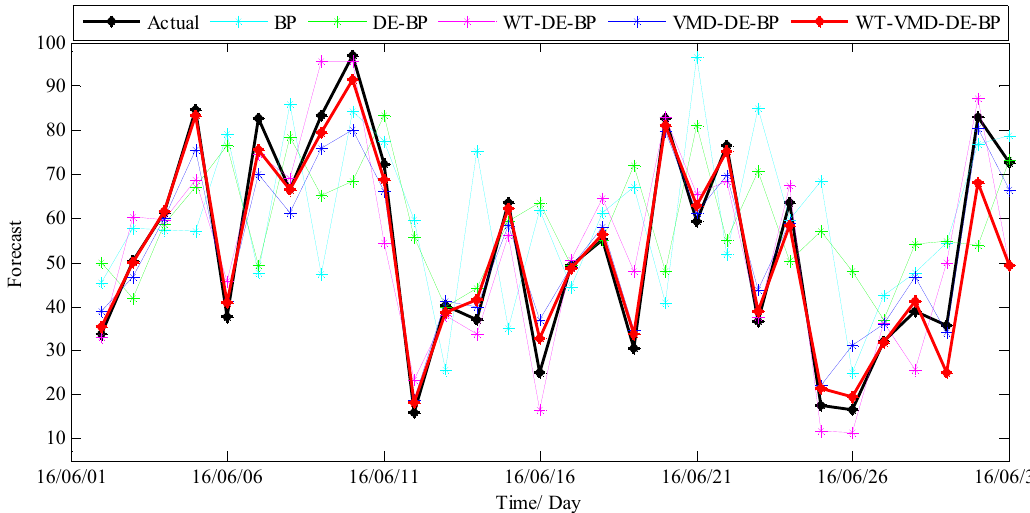
Figure 18. The ultimate forecast results of different models (Tianjin). Table 4. Comparison of prediction performances of different models (Tianjin).